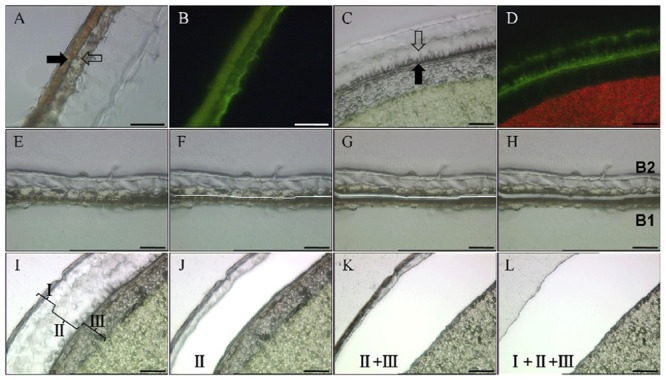
Anatomical pictures and workflow of laser microdissection (LMD) taken with a HV-D20P camera integrated in the LMD 6000 micro dissection system. (A,B) Micrographs of part B of mature flaxseed coats under light and fluorescence, respectively. The full arrow shows SCs, and the empty arrow shows PCs. Bars represent 100 μm. (C,D) Anatomical structures of 25 DAF seed coats under light and fluorescence. Developing SCs and PCs are marked by full and empty arrows, respectively. Bars represent 50 μm. The fluorescence optic settings are as follows: excitation = 450–490 nm, dicroic mirror = 510 nm, and emission = 515 nm. (E–H) The LMD work flow of dividing part B is as follows: (E) Tissue of part B before laser cutting, (F) drawing a cutting line using the software of the laser microscope, (G) laser cutting alongside the software-drawn line, and (H) separated subparts B1 and B2 after cutting. Bars represent 100 μm. (I–L) Work flow of separating 25 DAF seed coats into three parts I to III. (I) Tissue of immature seed coats before laser cutting, (J) tissue after cutting part II, (K) tissue after successively cutting parts II and I, (L) tissue after successively cutting parts II, I and III. Bars represent 50 μm. DAF, days after flowering; PC, parenchymatous cell; SC, sclerified cell.